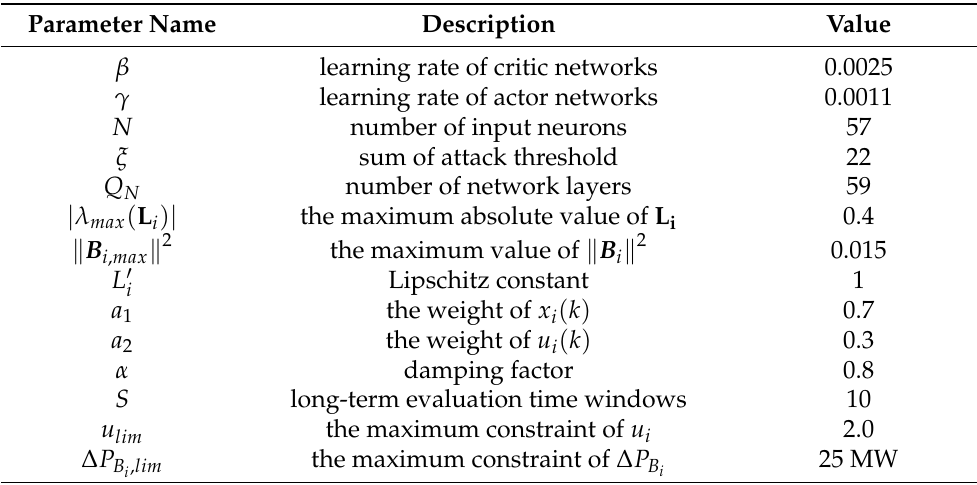
Table 4. Learning parameters of the IEEE 57 bus testing